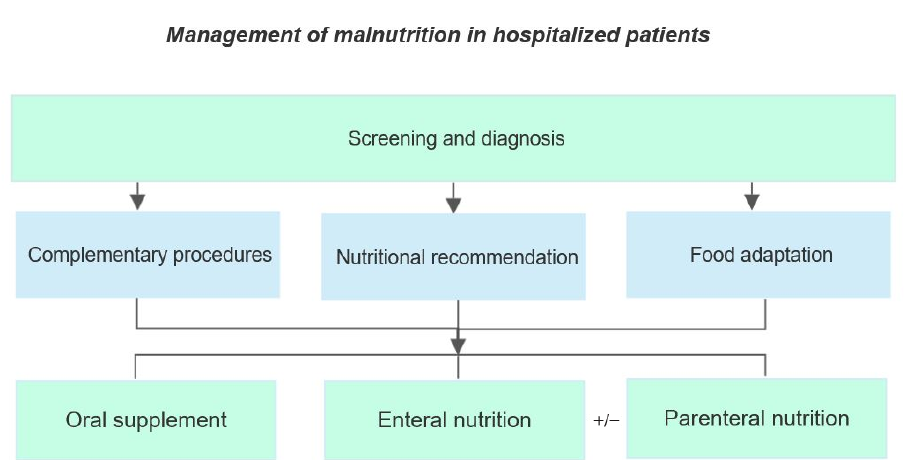
Figure 2. Intervention strategies to prevent or treat malnutrition according to ESPEN recommenda- tions [27,89].